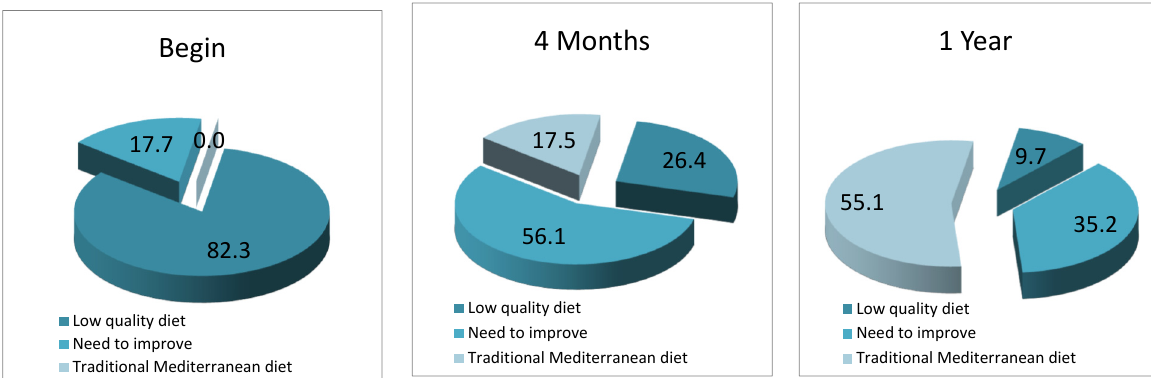
Figure 2. Evolution of quality of diet, measured using TMD Test. Table 8. TMD Test (%).